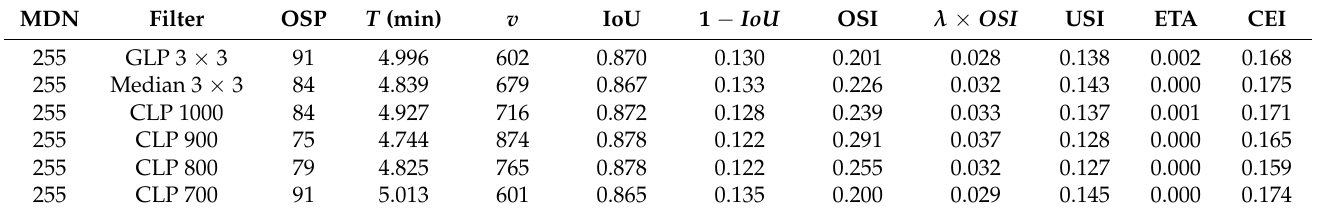
Table 8. Effects of spatial filtering on segmentation evaluation parameters of compressed